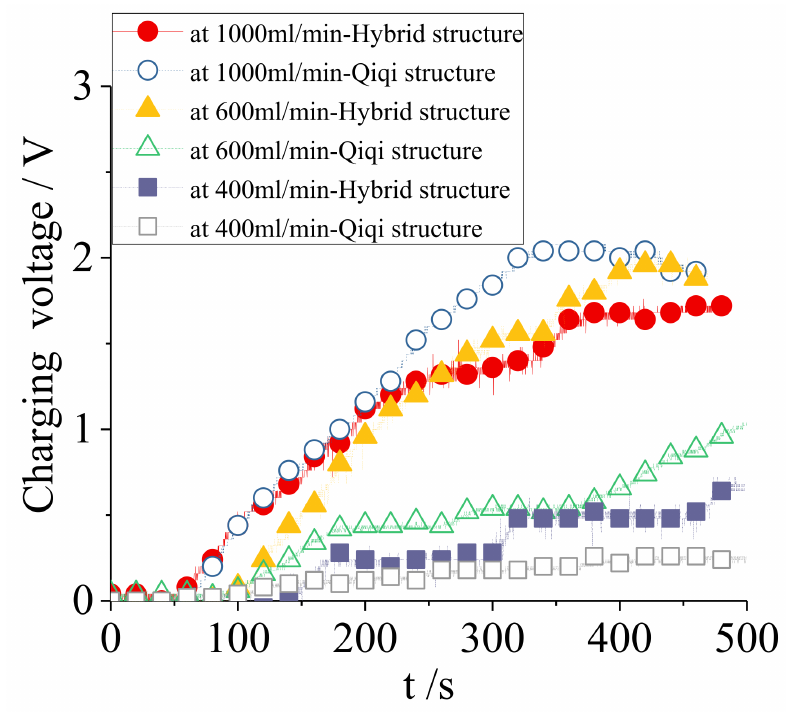
Figure 11. Charging process under different water flow conditions.